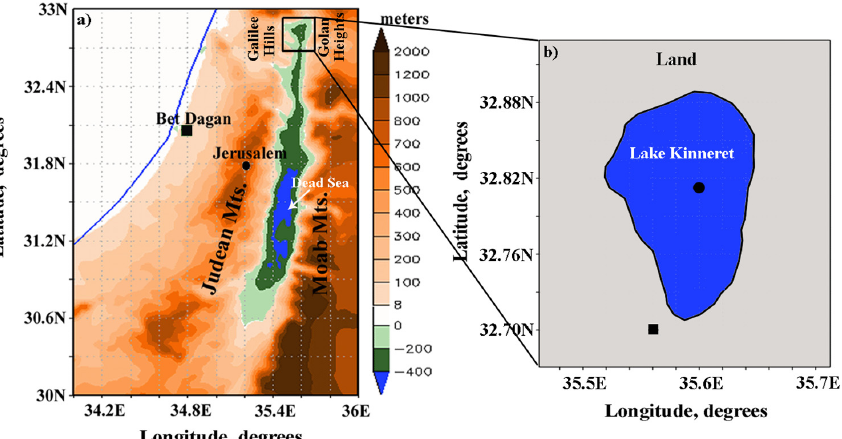
Figure 1. ( a ) Topographic map of the south-east Mediterranean region, and ( b ) geographic map of the region under study including Lake Kinneret and surrounding land areas. The black circle shows the location of ship measurements of water temperature (32.81°N, 35.60°E), while the black square shows the location of the Zemah meteorological station (32.70°N, 35.58°E).